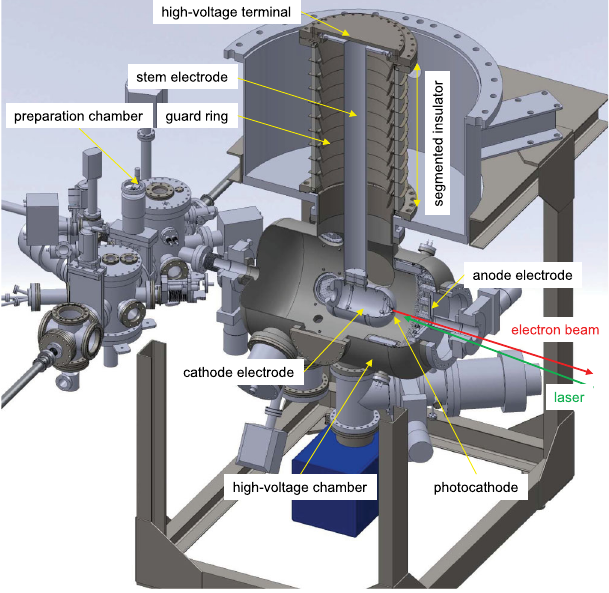
FIG. 1. 500-kV dc photoemission gun at